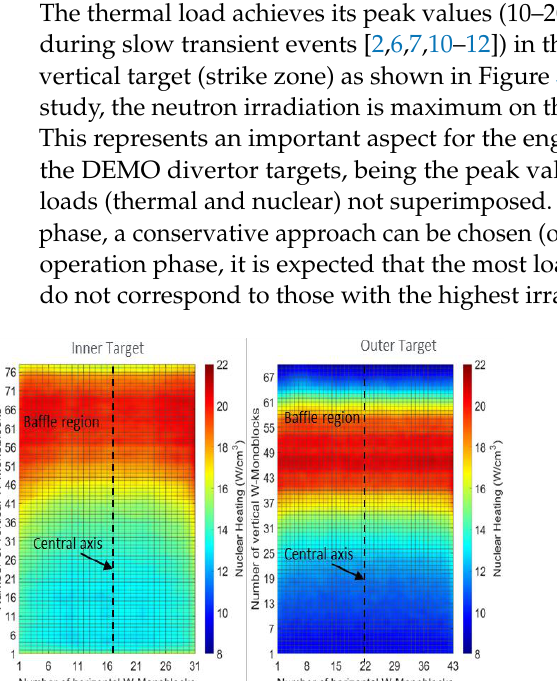
Figure 30. Maps of the nuclear heating density (W/cm 3 ) spatial distribution on the W-monoblocks of the inner ( left ) and outer ( right ) target, considering the WCLL blanket, showing in superimposition the baffle region and central symmetry axis of the targets.